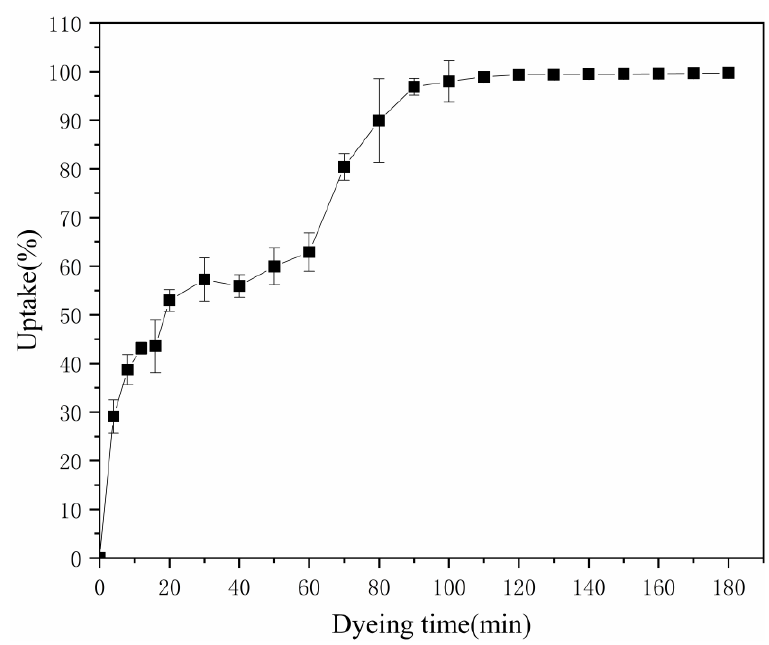
Figure 5. Effect of dyeing time on uptake of the self-dispersing pigments.